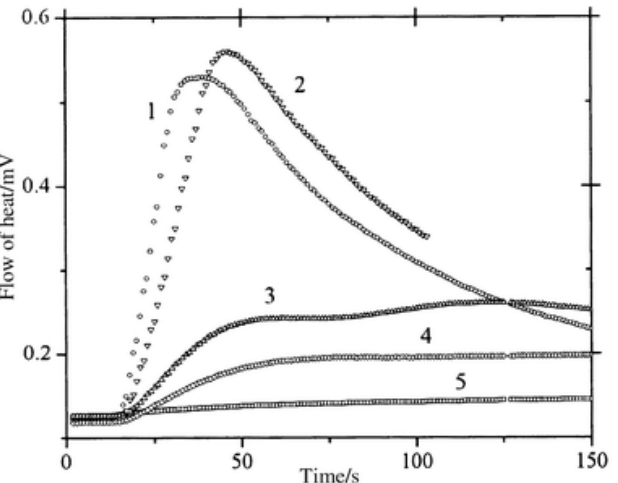
Figure 6. Polymerization profiles obtained by photo-DSC using (1) CICl2, (2) CI, (3) ZB, (4) ZH, (5) CNH2 in combination with NPG. Reproduced from Ref. [217] with permission from the Royal Society of Chemistry.